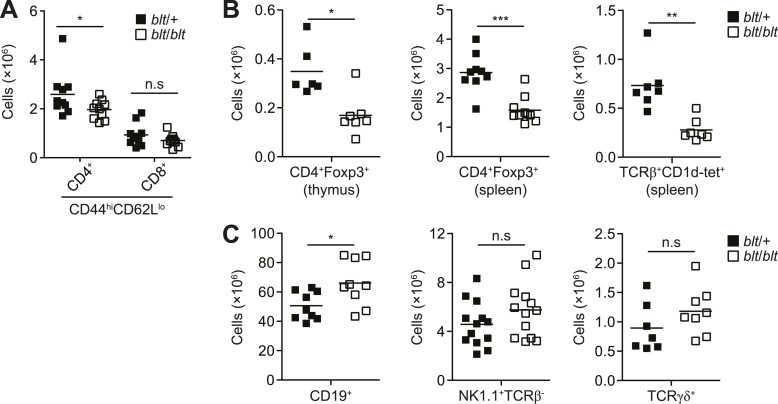
blt/blt mice exhibit a selective defect in αβ T cells.(A) Number of effector/memory phenotype
(CD44hiCD62Llo) CD4+ and
CD8+ T cells in the spleen. (B) Number of
Foxp3+ CD4SP thymocytes (left), splenic
Foxp3+CD4+ Tregs (center), and splenic iNKTs
identified by positive CD1d tetramer staining (right). (C)
Number of splenic B cells (CD19+; left), NK cells
(NK1.1+TCRβ+; center), and γδ T cells
(TCRγδ+; right). n.s, not significant; *p < 0.05, **p
< 0.01, ***p < 0.001 (two-tailed Mann-Whitney test).